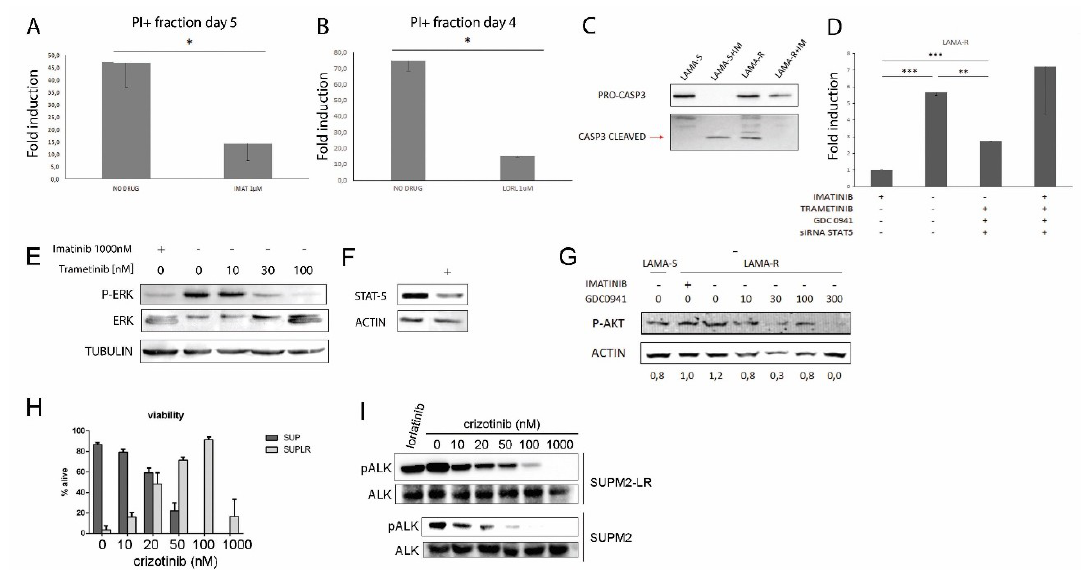
Figure 4. Drug addicted cells die upon drug withdrawal. Simultaneous inhibition of three downstream pathways partially rescue drug addiction-induced cell death. ( A ) PI+ fraction is detected on LAMA-R cells 5 days upon imatinib withdrawal. ( B ) PI+ fraction is detected on SUP-M2-LR cells 4 days upon lorlatinib withdrawal. ( C ) Cleaved caspase 3 was detected five days upon drug withdrawal in LAMA-S and LAMA-R. ( D ) Cells were treated with the indicated drugs at doses: IMATINIB (ABL inhibitor), 1 µ M. TRAMETINIB (MEK inhibitor), 30 nM. GDC0910 (PI3K inhibitor), 100 nM. siRNA STAT5, 50 nM. LAMA-R cells were transfected or not with STAT-5 siRNA in the presence of imatinib, then after 24 h they were challenged with one or a combination of inhibitors. Five days after drug withdrawal cells were collected and the PI+ fraction was evaluated by flow cytometry. The histogram indicates the average of at least two independent experiments ( E , F , G ) The efficiency of target inhibition in LAMA-R cells was detected by western blot after 4h (panels E and G) or 24 h (panel F). ( H ) 1 h after lorlatinib withdrawal, cells were treated with the indicated crizotinib doses. Cell viability was assessed by trypan blue count after four days. ( I ) The efficiency of target inhibition in SUP-M2-LR cells was detected by western blot 4 h after crizotinib treatment. * p < 0.05, ** p between 0.05 and 0.01 *** p < 0.01. + and − indicate the presence or the absence of the